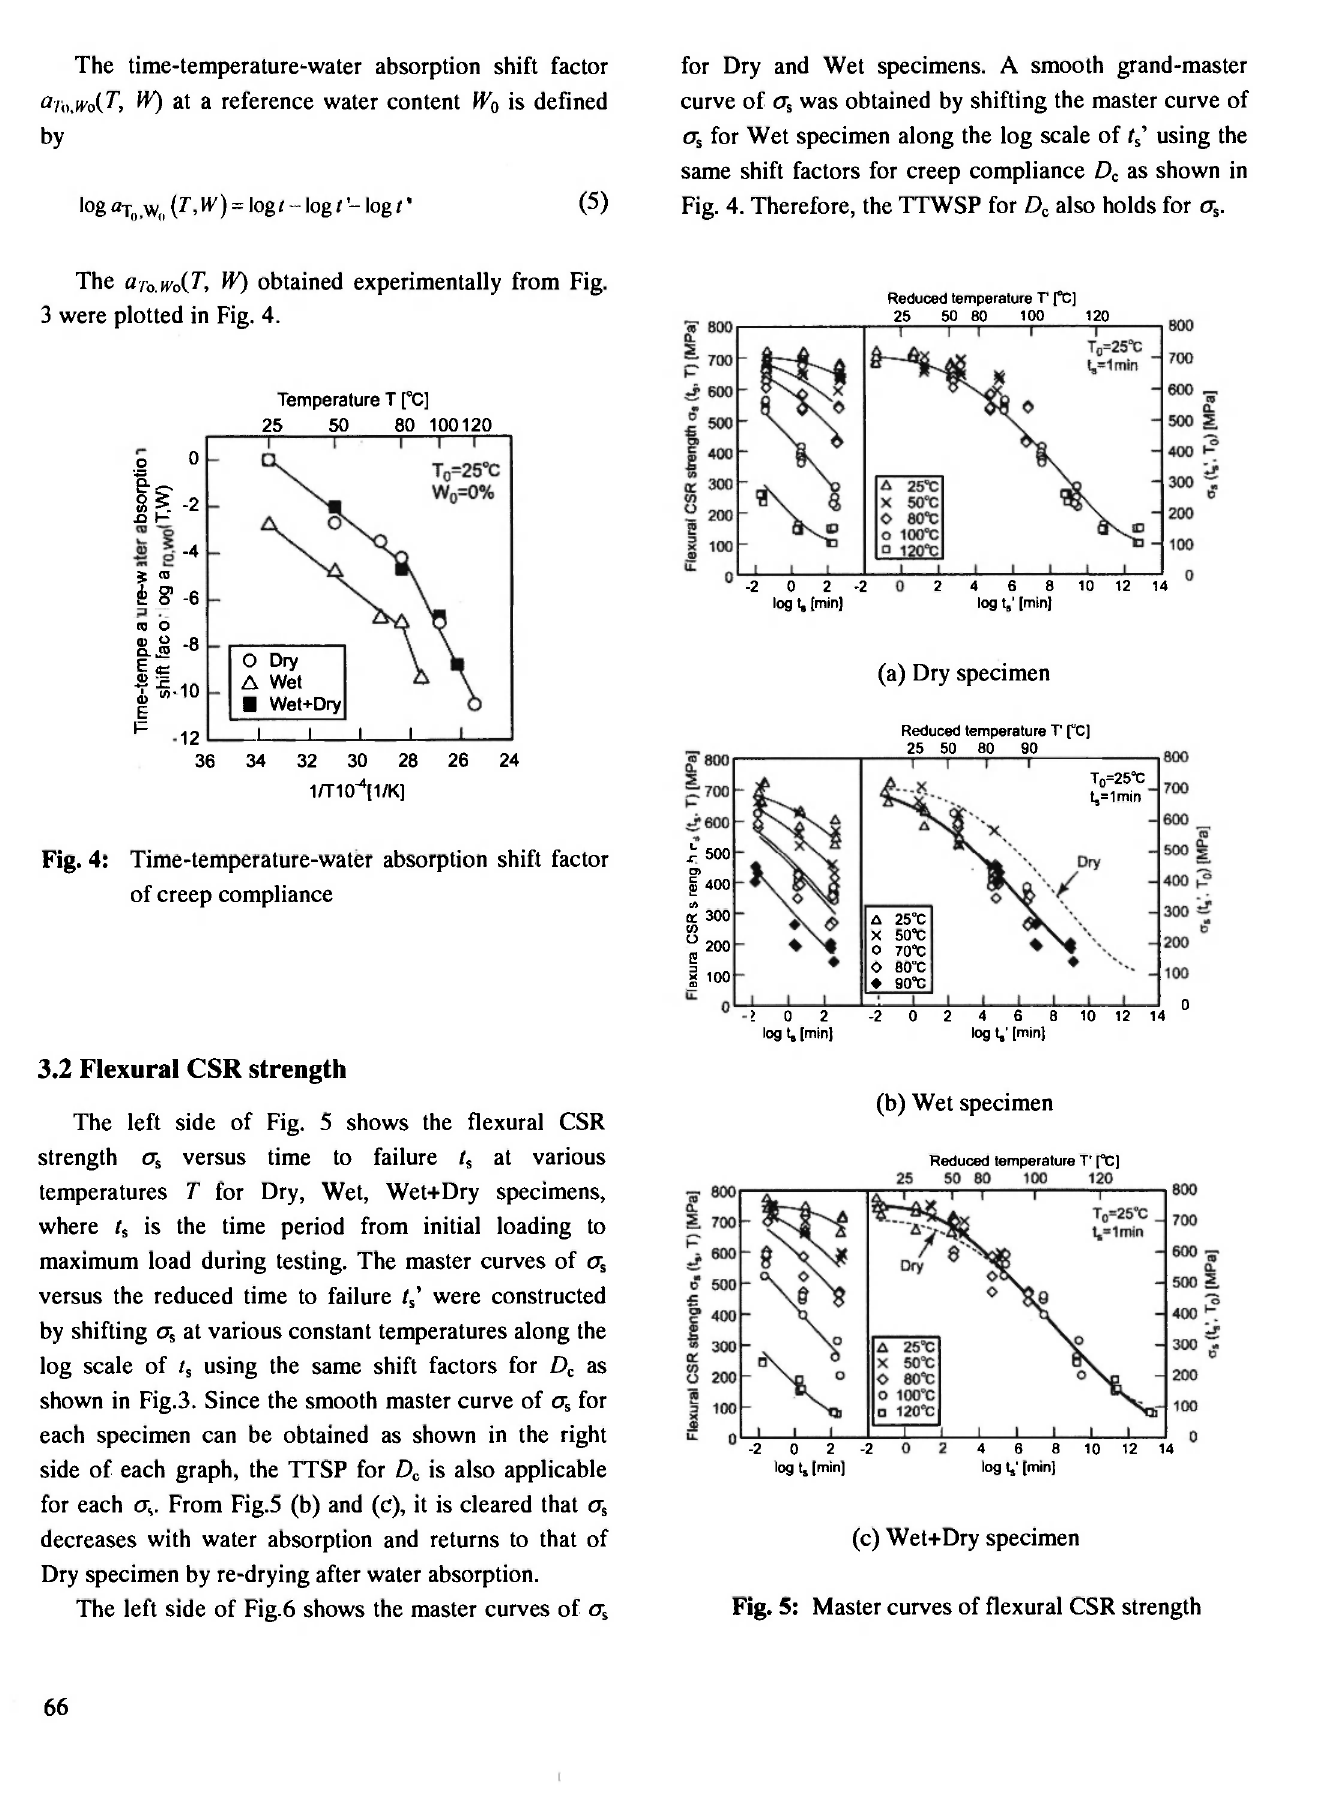
Fig. 5: Master curves of flexural CSR